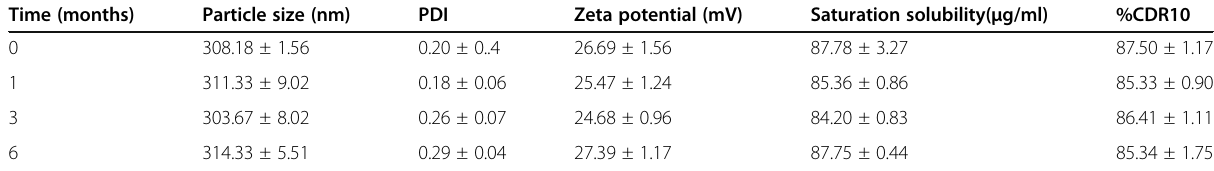
Table 6 Accelerated stability studies data at 40 °C/75% RH Time